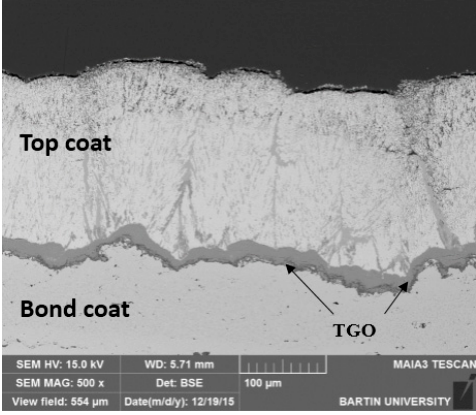
Figure 3. Cross-sectional microstructure of YSZ TBC after the hot corrosion test.